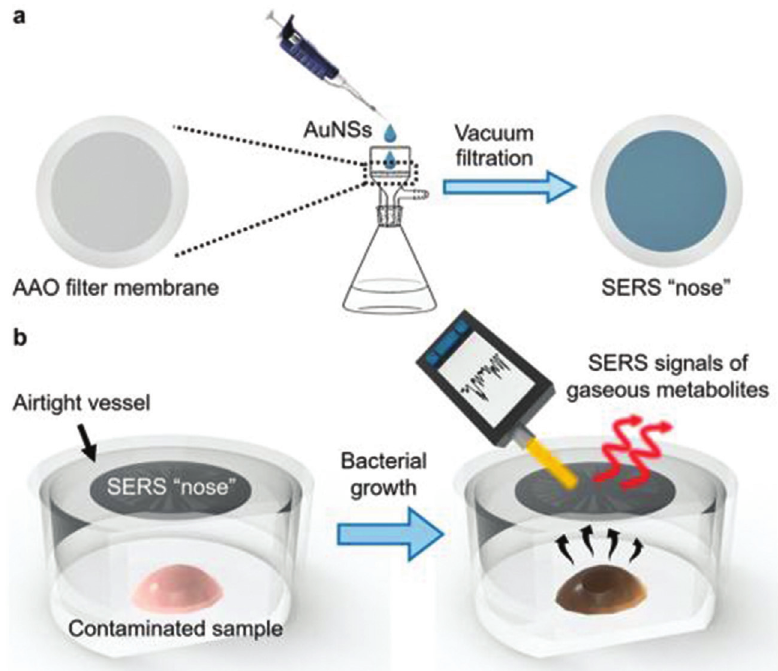
Figure 5: Schematic illustration of Fabrication of SERS “nose” and its application in point-of-care SERS monitoring of gaseous metabolites from contaminated sample. Reproduced with permission from Ref. [25]. Copyright: 2020 American Chemical